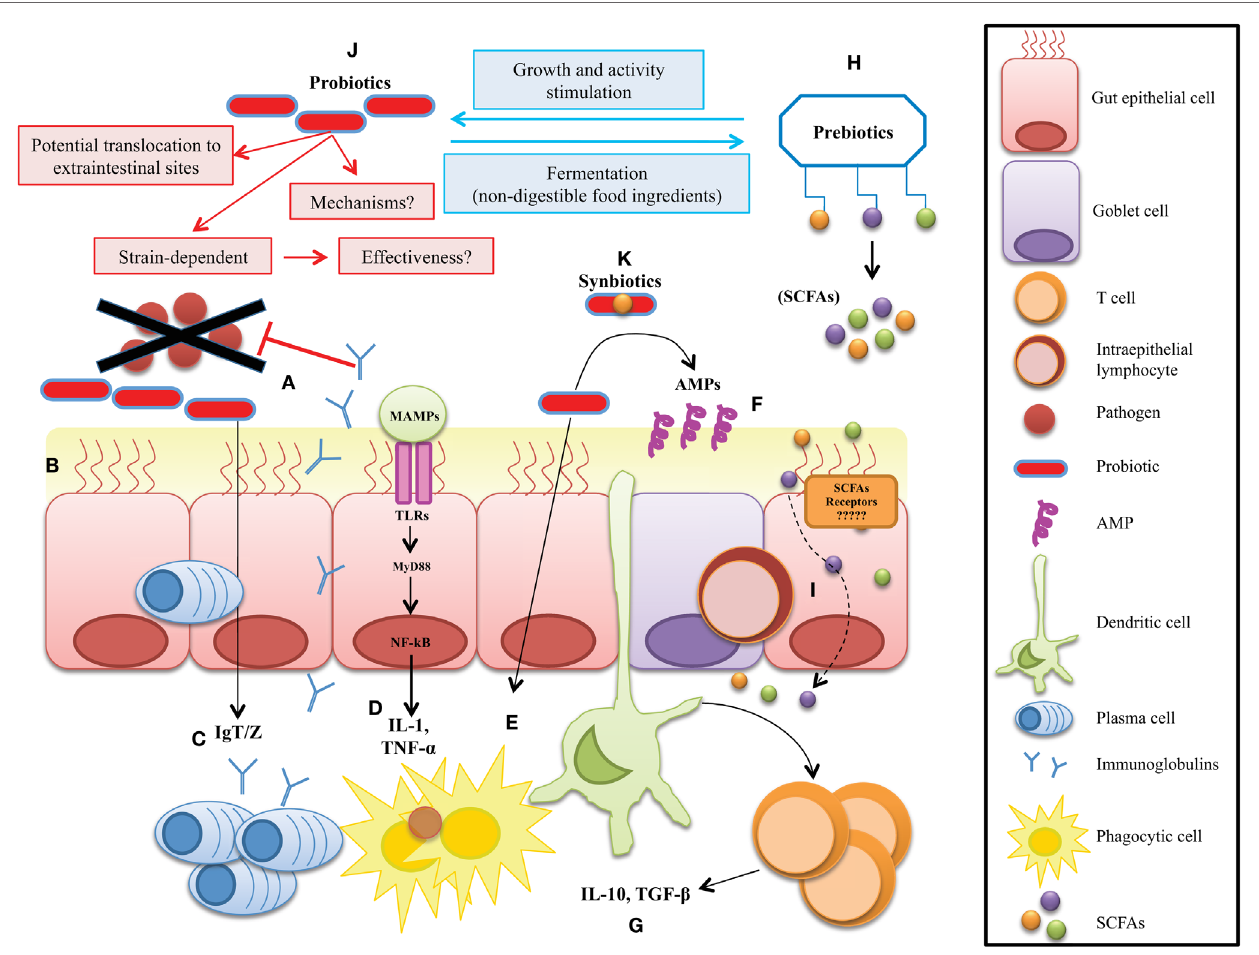
FiGURe 1 | Potential microbial strategies to improve gut mucosal immunity in fish . The therapeutic approach mechanisms include: (A) competitive exclusion for binding sites and translocation, (B) enhanced barrier function by reversing the increased intestinal permeability, (C) enhanced mucosal immunoglobulin IgT/Z response to enteral antigens, (D) reduction of secretion of inflammatory mediators, (e) stimulation of innate immune functions, (F) stimulate the release of antimicrobial peptides (AMPs) at the mucosal layer, and (G) enhanced availability of anti-inflammatory mediators by regulatory immune cells. (H) Production of metabolic health-enhancers like SCFAs by non-digestible prebiotics, (i) diffusion of SCFAs through the enterocytes to improve mucosa barrier functions. (J) Probiotics have been suggested to confer several health benefits on the host. However, their mechanisms of action are not well understood. (K) Synbiotics are a mix of pre- and probiotics, thus their mode of action are much more difficult to